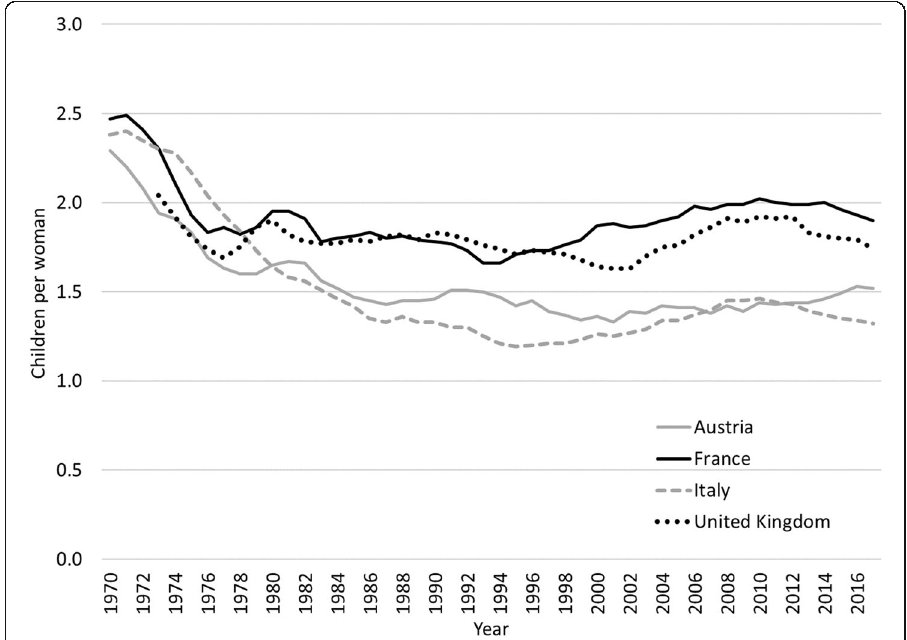
Fig. 2 Total fertility rate (TFR) in four European countries since 1970. Source: Eurostat